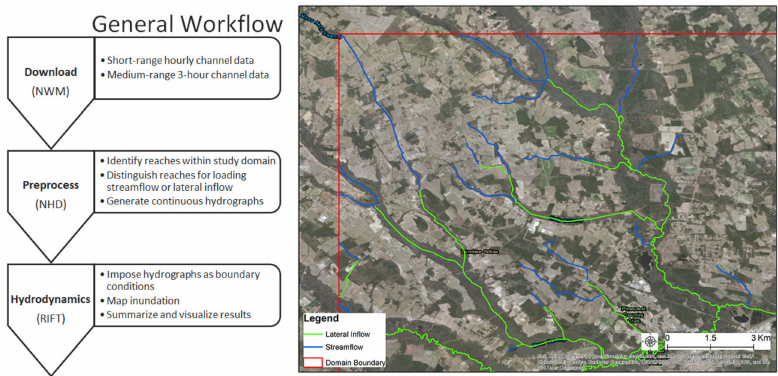
Figure 2. General workflow and an example network of the river reaches to be loaded by lateral inflow and streamflow boundary